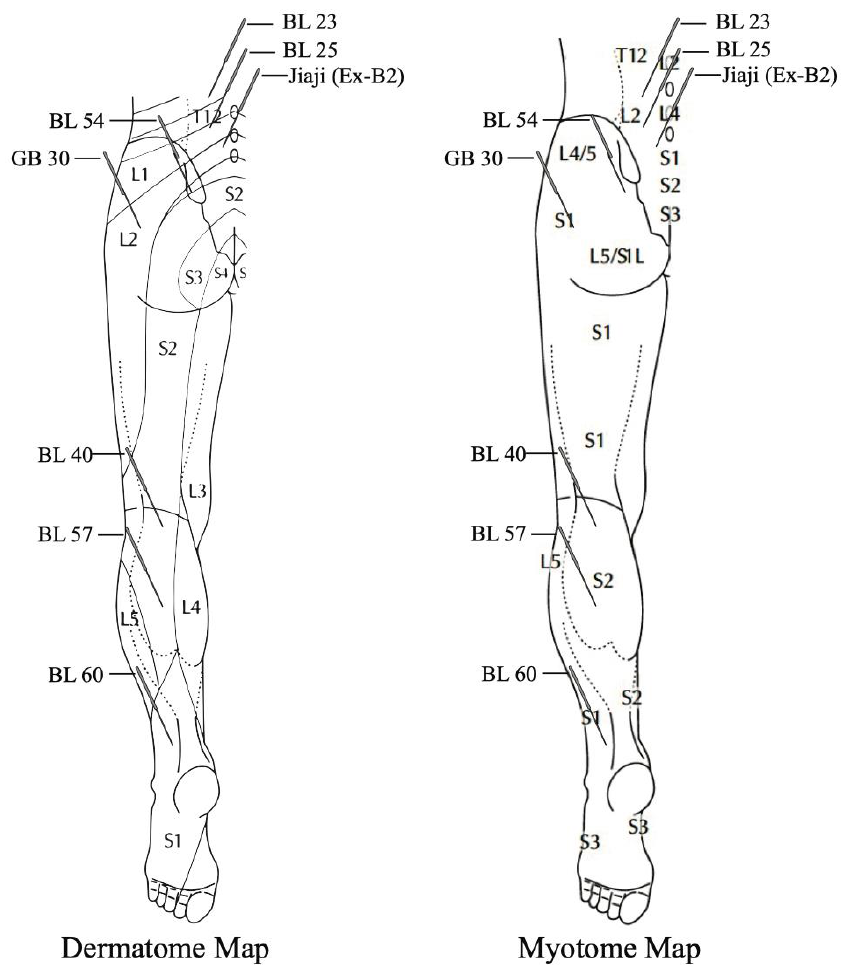
Figure 2. Schematic illustration of acupuncture points most commonly used across studies in their anatomic dermatome and myotome region. BL: bladder; Jiaji: huatuojiaji; GB: gallbladder.